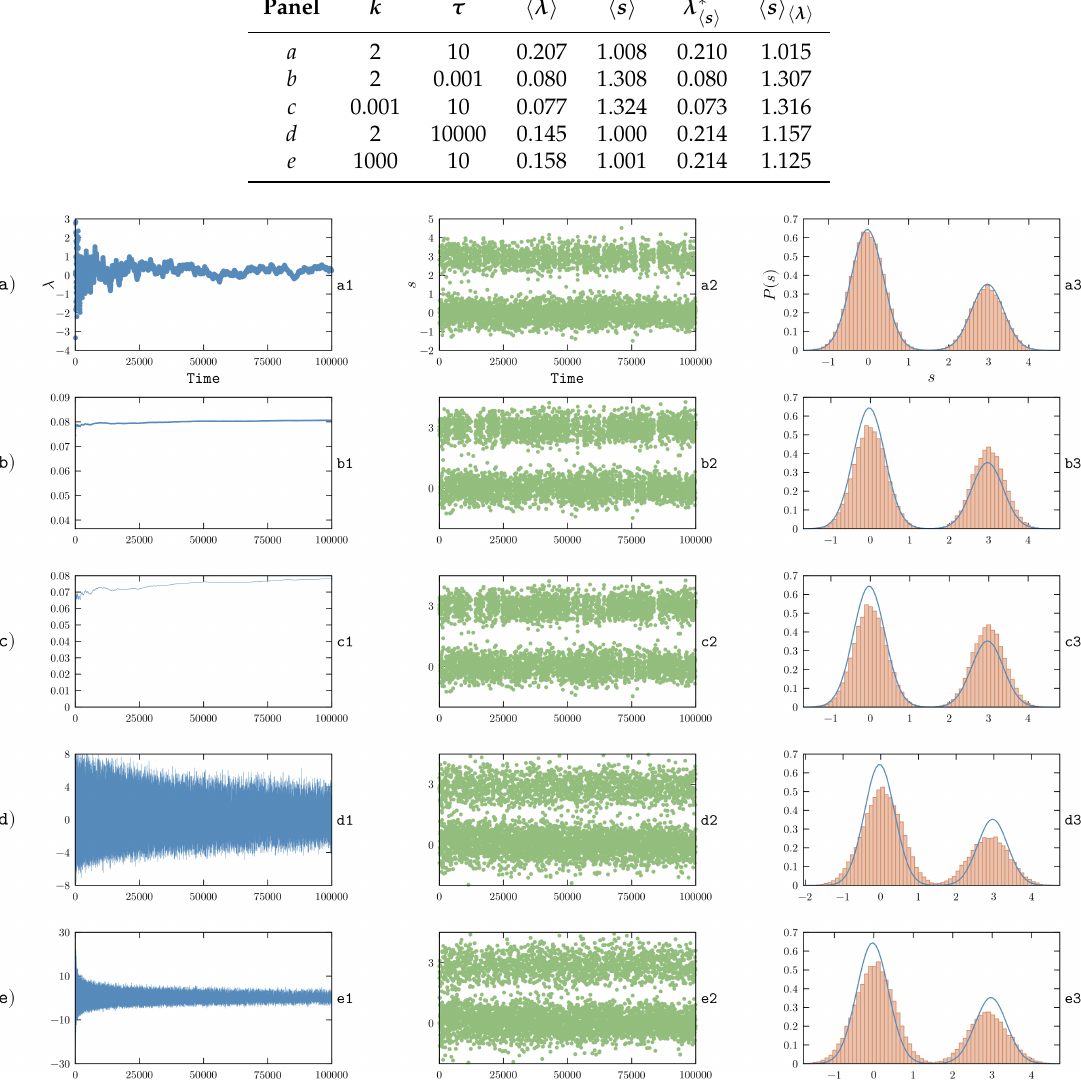
Figure 5. Effect of choosing different values for k and τ when using stochastic gradient descent (SGD) on-the-fly during molecular dynamics (MD) simulations. Panel labels ( a – e ) refer to different sets of k and τ values matching those of Table 1. In particular, for each set of k and τ we show the convergence of the Lagrangian multipliers (number 1 of each letter), the time series of the observable (number 2 of each letter), and the resulting sampled posterior distribution, red bars, together with the analytical result, continuous line (number 3 of each